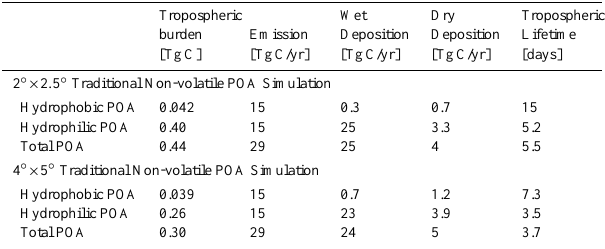
lower isoprene emissions, presumably due to differences